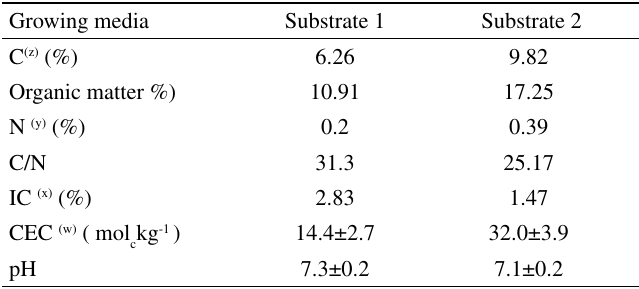
Table 2 - Chemical characteristics of growing media Growing